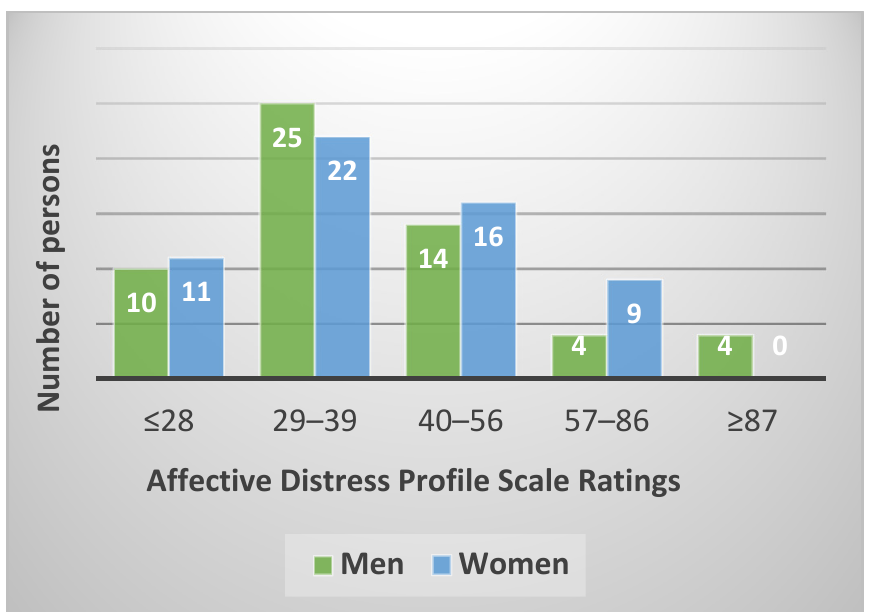
Figure 1. PDA by category depending on sex. ≤ 28: very low level of distress, 29–39: low level of distress, 40–56: medium level of distress, 57–86: high level of distress, ≥ 87: very high level of distress.